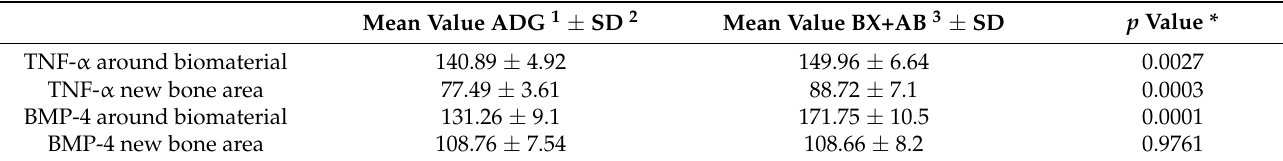
Table 4. Immunohistochemical intensity score